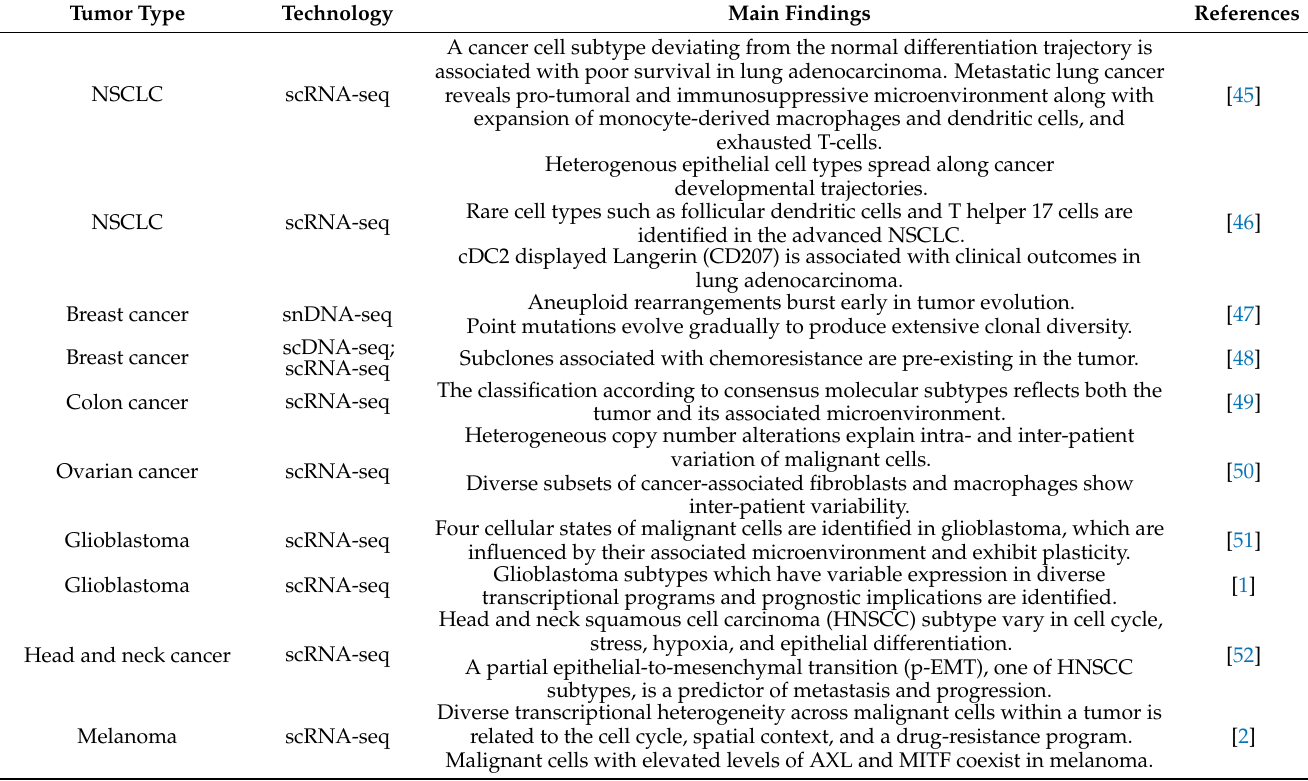
Table 2. Single-cell studies dissecting tumor signatures and specific